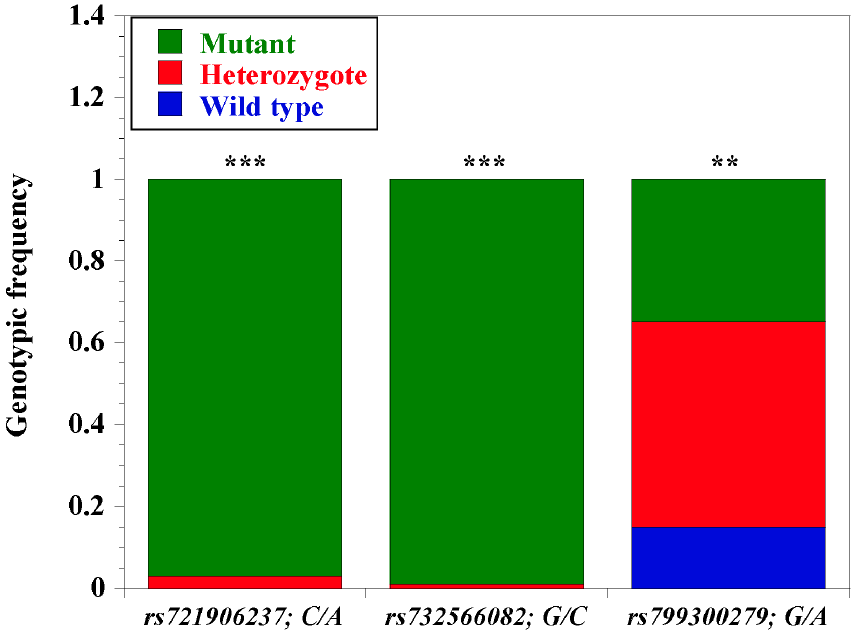
Figure 5. Genotypic frequency of three selected N’Dama-specific CD14 gene promoter single nucleotide polymorphism . We elucidated the genetic diversity of three (out of 13) selected N’Dama-specific SNPs ( n = 103) using Taqman SNP genotyping assay (ThermoFisher). Blue bars: Wild type variant; red bar: Heterozygotes; green bars: Mutant variants. The three SNPs are rs721906237 ; C / A; rs732566082 , G / C; and rs799300279 , G / A; *** significant ( p < 0.0001); ** ( p < 0.001); * ( p < 0.01). Table 6. Estimated haplotype frequencies of selected N’Dama-specific CD14 gene promoter SNPs. Haplotype Definition Haplotype